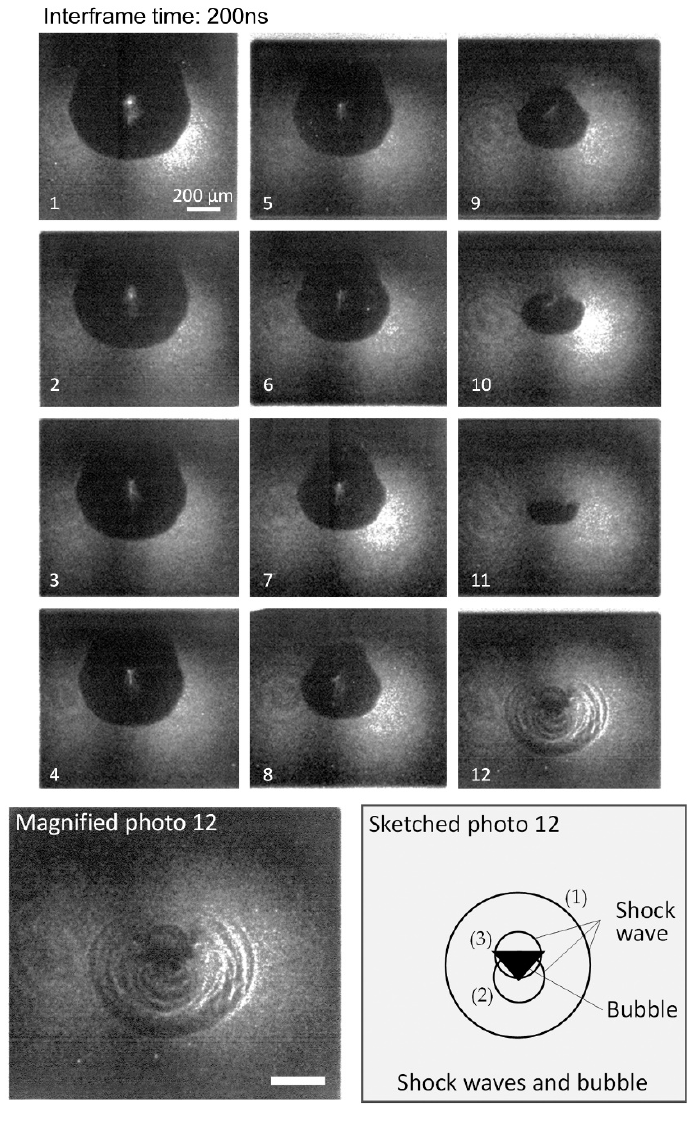
Figure 4. High − speed video imaging of the collapse of a quasi-spherical bubble. The series of photos are numbered 1 to 12 over time. The collapse is not perfectly spherical, which denotes the formation of a microjet. Several shock waves are visible at the collapse (photo 12, magnified photo 12), and drawn on the sketch of the main shock waves and the collapse bubble (sketched photo 12 (bottom-right)). The shocks are assumed to be a water hammer shock wave (1) and compression shocks waves (2) and (3) in the sketch. This collapse type is classified to the quasi-spherical bubbles. Camera settings are: 5 million frames/s, and 5 ns exposure time. The scale bar is 200 µm.